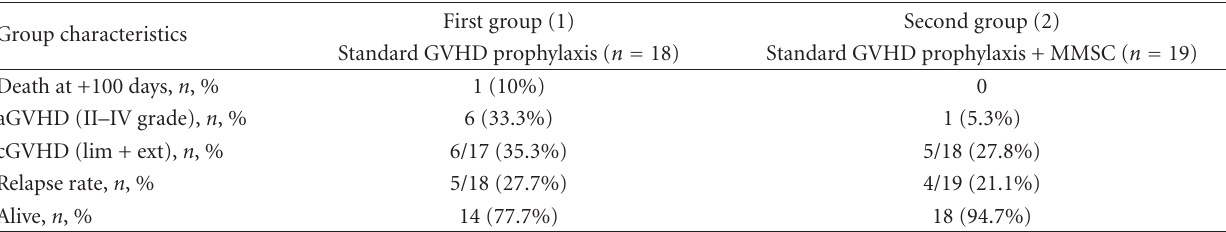
Table 4: Patients’